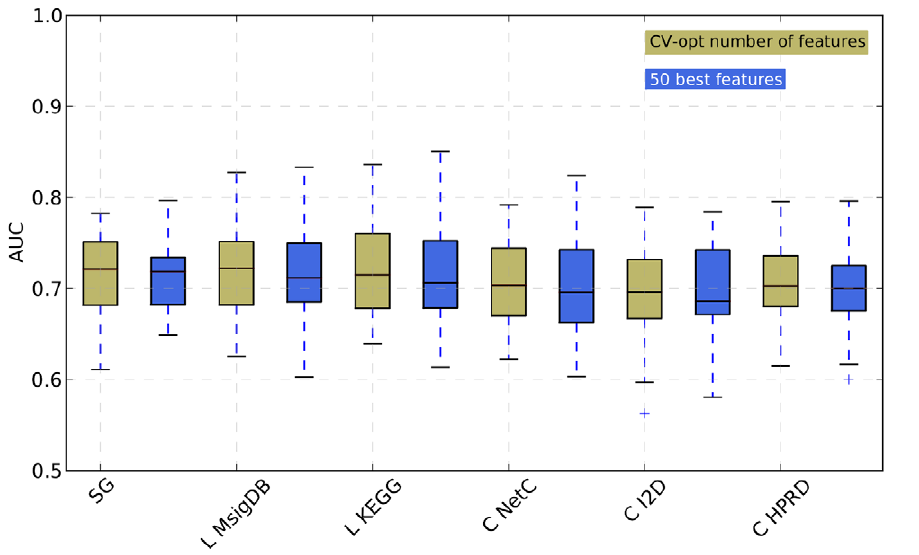
Figure 3. Performance of all classifiers restricted to 50 features. Comparison of the performance of the classifiers when the number of features is trained in the CV procedure (denoted as ‘CV-opt number of features’, same values as in Figure 2) and when the 50 best scoring features (denoted as ‘50 best features’) are selected for classification. We cannot show the values for Chuang -KEGG, Taylor -KEGG or Taylor -HPRD since for some data sets, the number of significant composite features was lower than 50. Abbreviations of methods as in Figure 2.